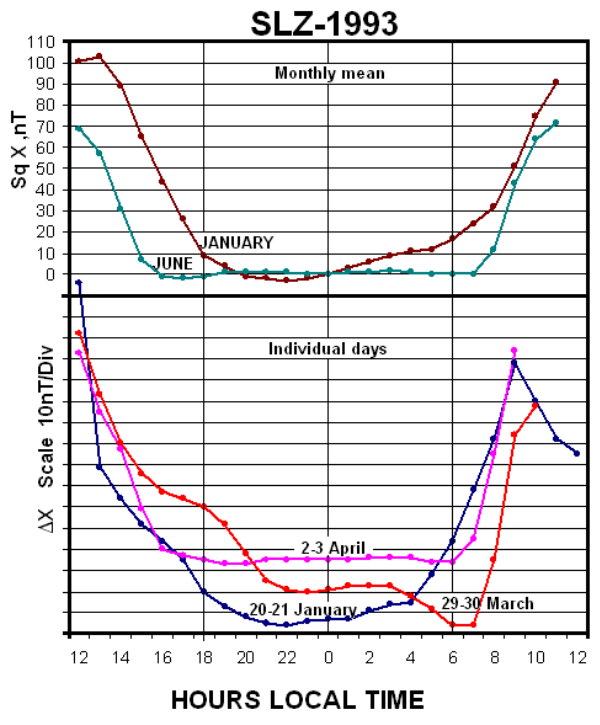
Fig. 16. Daily variations of SqH at Sao Luiz (SLZ) averaged for January and June 1993 and for individual days 20–21 January, 29– 30 March and 2–3 April